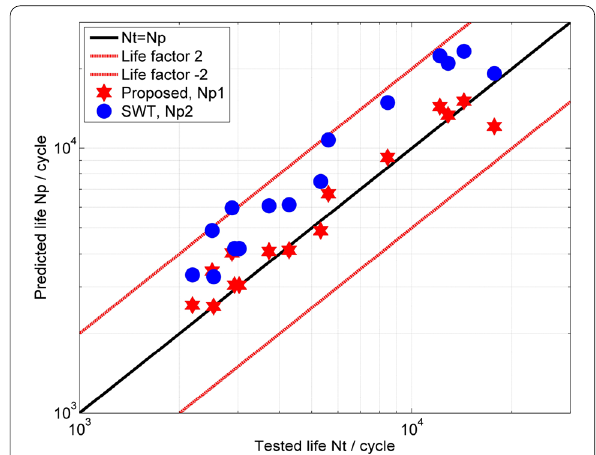
0 = Figure 8 Predicted lives vs. tested lives of GH4133